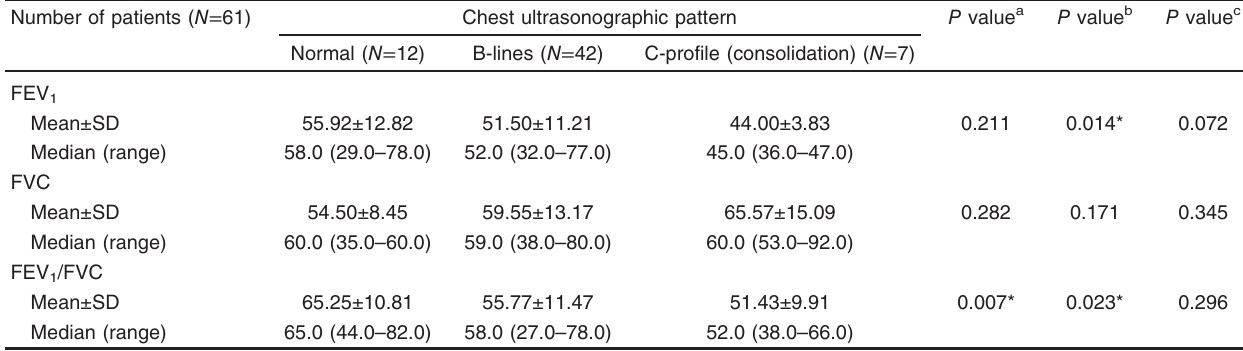
Table 4 Correlation between chest ultrasound pattern and pulmonary function test in patients with bronchiectasis Number of patients ( N = 61) Chest ultrasonographic pattern